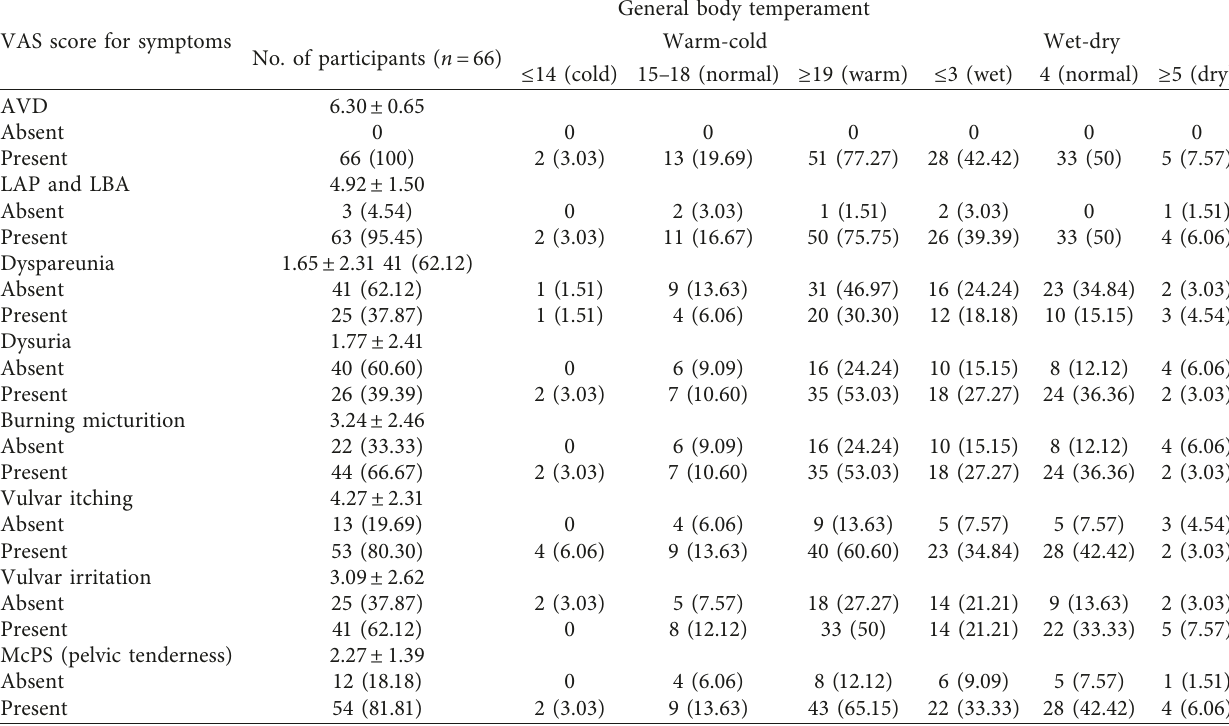
Table 3: Abnormal vaginal discharge, its associated symptoms, and general